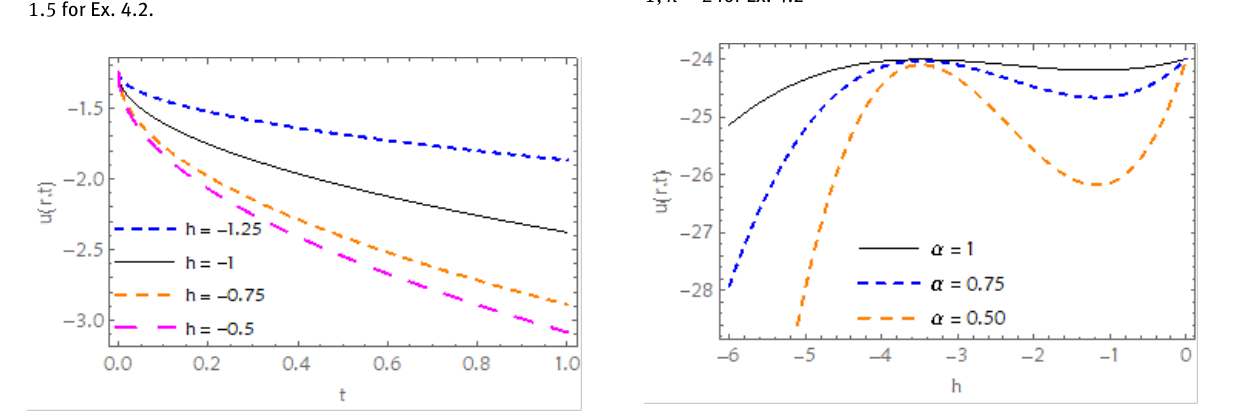
Fig. 11: h -curve of solution u ( r , t ) Vs. (cid:126) obtained when t = 0.01, r = 1, n = 2 for Ex. 4.2